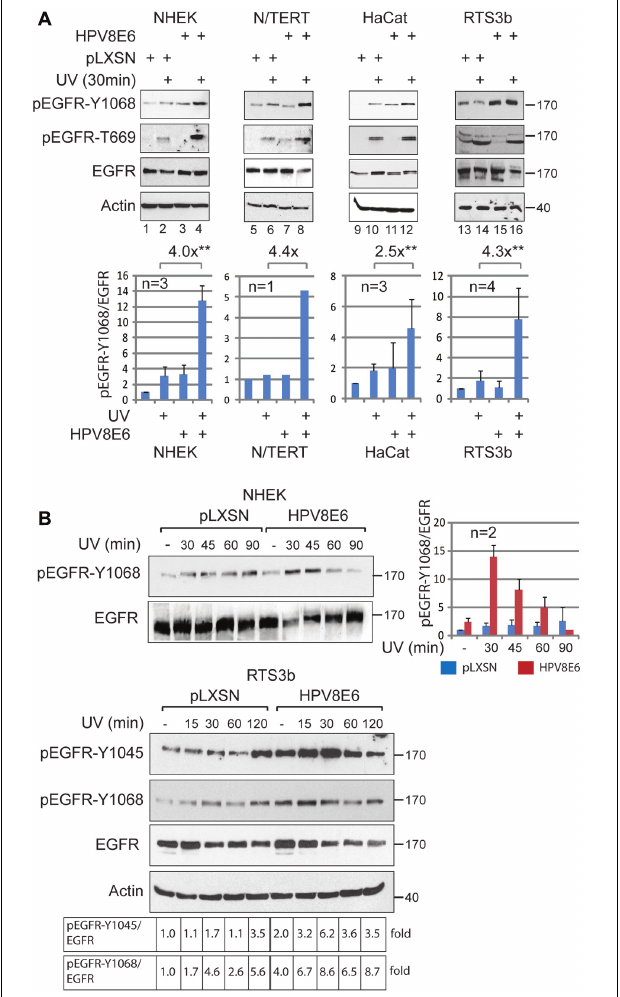
FIGURE 1 | HPV8E6 increases the rate of tyrosine-phosphorylation of the EGFR after UV-irradiation. (A) Normal human epithelial keratinocytes (NHEK), N/TERT, HaCat and RTS3b cells, harboring either pLXSN or pLXSN-HPV8E6, respectively, were left untreated or irradiated with UV light and further cultivated for 30 min. Protein extracts were used for a WB developed with antibodies as indicated in the figure. Shown is one representative blot for each cell line. The signals were quantitated and the average ratio of pEGFR-Y1068 versus total EGFR obtained with three to four independent experiments, as indicated, were given in the graph for NHEK, RTS3b, and HaCat cells. The fold changes of the pEGFR-Y1068 versus total EGFR in UV-irradiated cell due to the expression of HPV8E6 are given. The ratios with N/TERTS are from one experiment ( ∗∗ p < 0.05). (B) PLXSN-HPV8E6 or empty vector harboring NHEK and RTS3b cells were UV-irradiated and harvested at the indicated time points later. The pEGFR-Y1068, (pEGFR-Y1045 in the case of RTS3b) and the total EGFR were detected by WB. Shown is one representative example out of two experiments using NHEK, which both were used for quantifications shown in the figure. The values of the quantification of WB with the RTS3 cells are given as well. The positions of the molecular weight markers are given (in